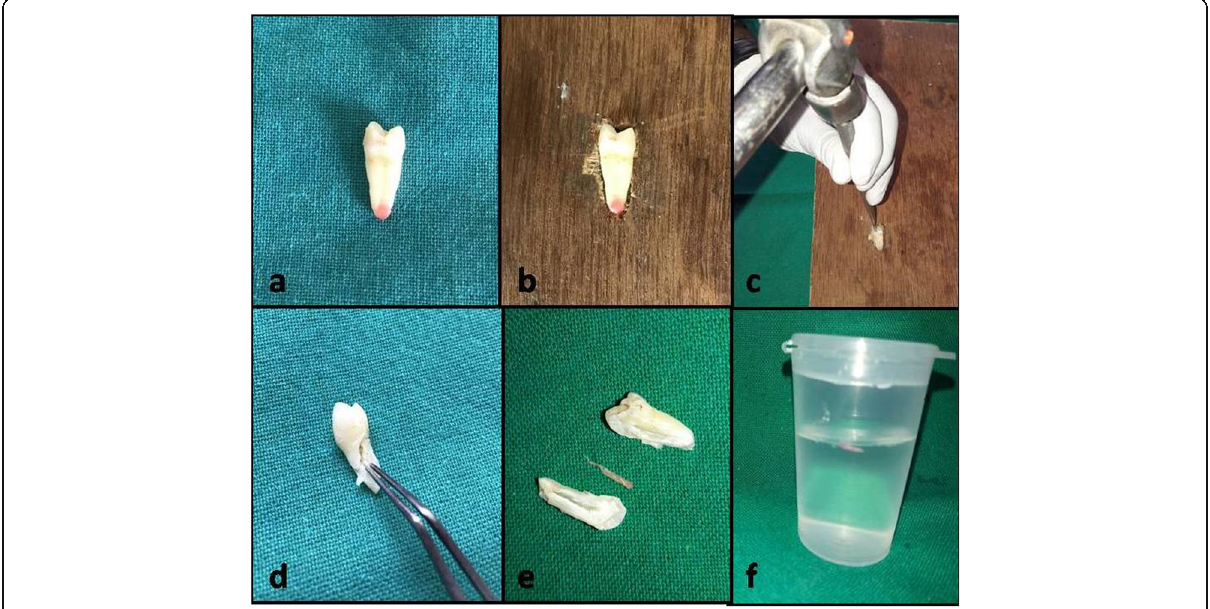
Fig. 1 Procedure for pulp retrieval. a Apical foramen blocked with modeling wax after extraction. b The tooth placed in the shallow depression of a wooden block accommodating the tooth shape. c The tooth split with chisel and mallet. d Pulp retrieval with a pair of forceps. e The retrieved pulp. f Pulp tissue fixed in 10% buffered